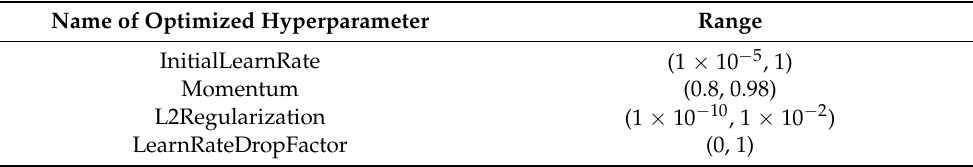
Table 4. Bayesian Optimized Variable Setting.